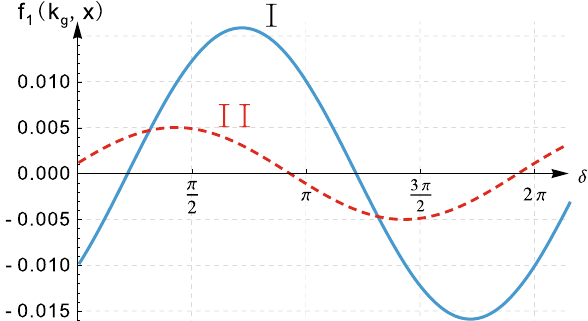
Fig. 9 Relation curves between the matching function f ( k g , x ) and the phase δ . In fact, δ is the phase difference between the coherent non- stochastic HFGW and the GB in the 3DSR system. It is shown that, for the parameters ν e = ν g = 3 × 10 9 Hz, W 0 = 0 . 06m, y ∈ [ 0m , 0 . 1m ] , z ∈ [ 0 , 0 . 3m ] , (i.e., Δ s = 3 . 0 × 10 − 2 m 2 ) and the matching function f ( k g , x ) at the longitudinal symmetrical surface (i.e., the surface of x = 0), δ = 18 π/ 25 (or 2.26195) is the optimal phase, and f ( k g , x ) = 0 . 0159isthebestmatchingfunction.Forthematchingfunction f ( k g , x ) at the surface of x = 10cm), δ = 43 π/ 100 (or 1.35088) is the optimal phase, then f 1 ( k g , x ) = 0 . 00502 is the best matching